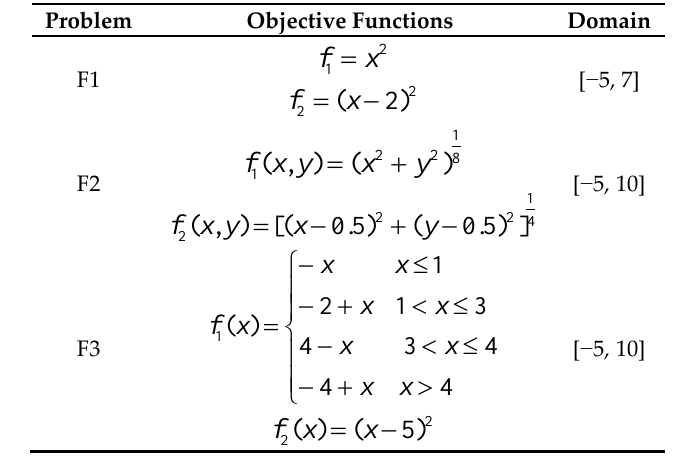
Table 2. Test problems used in this study.